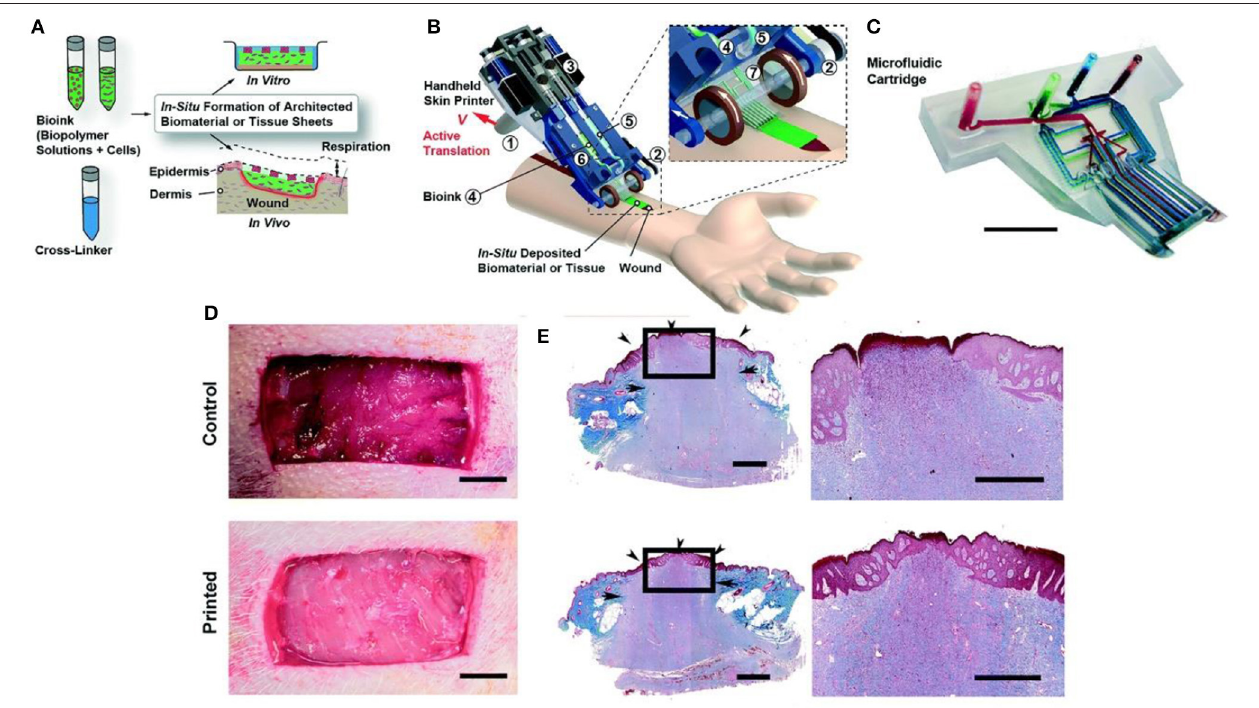
FIGURE 4 | Handheld skin microfluidic printer. (A) Schematic diagram illustrating working principle of handheld bioprinter. Bioinks (green) containing hydrogels and cells, and a cross-linker solution (blue) are prepared. (B) Schematic image of handheld bioprinter. (C) Image of 3D printed microfluidic cartridge. Scale bar 10mm. (D) Control wound and in situ printed of biomaterial sheet. (E) Granulation tissue formation and re-epithelialization confirmed by trichrome staining. Arrows indicate the border between newly formed granulation tissue and intact skin. Arrowheads mark epithelialized area. Arrowhead at the center of treated wound shows complete re-epithelialization, while central arrowhead in control wound shows non re-epithelialized zone at wound center. Scale bars 10mm (C, D) , 1mm ( E right), and 2mm ( E left). Reprinted with permission from Hakimi et al., 2018. Copyright 2018, Royal Society of